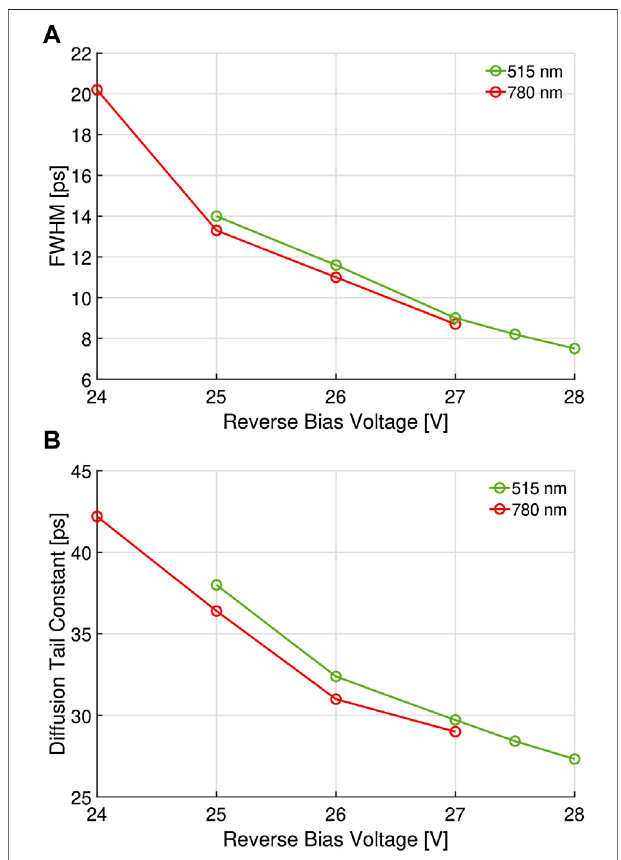
FIGURE5|(A) FWHMsingle-photontimingresolutionobtainedwiththe designed system. (B) Exponential tail time constant measured at various excessbiasvoltages.Fortheseexperimentstwowavelengthswereused:515 and 780 nm. The results show a timing jitter of ~7.5 ps FWHM for green and ~8.5 ps FWHM for red light at ~6.5 V of excess bias voltage.